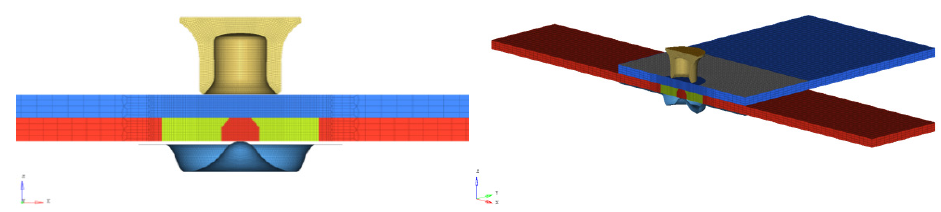
Figure 4. Half-section view of the FEA model for SPR joining.